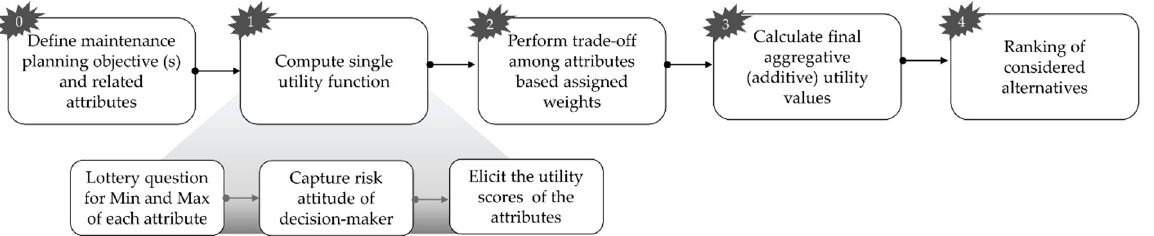
Figure 4. Flowchart for multi-attribute utility theory (MAUT) application.